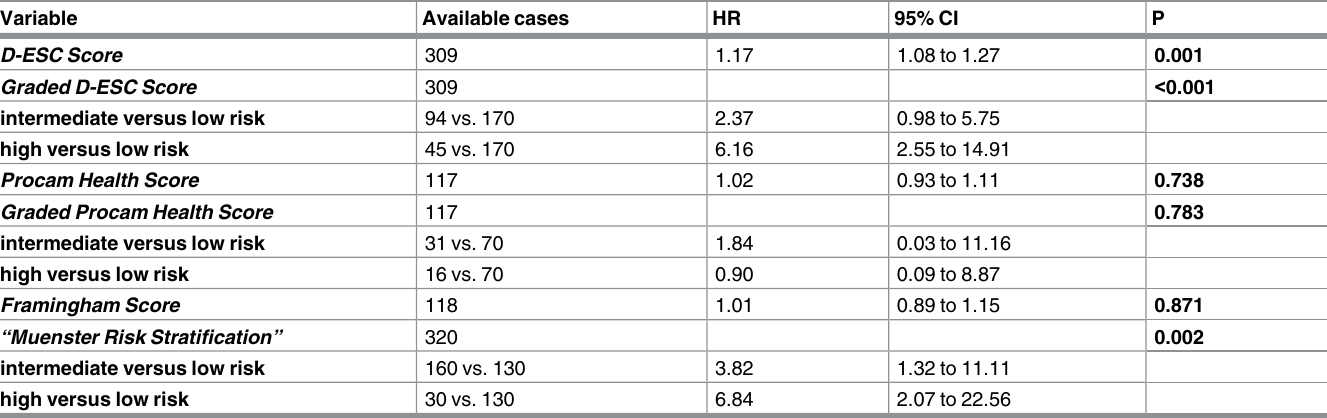
Table 4. Univariable analysis for event-free survival assessing different risk stratification